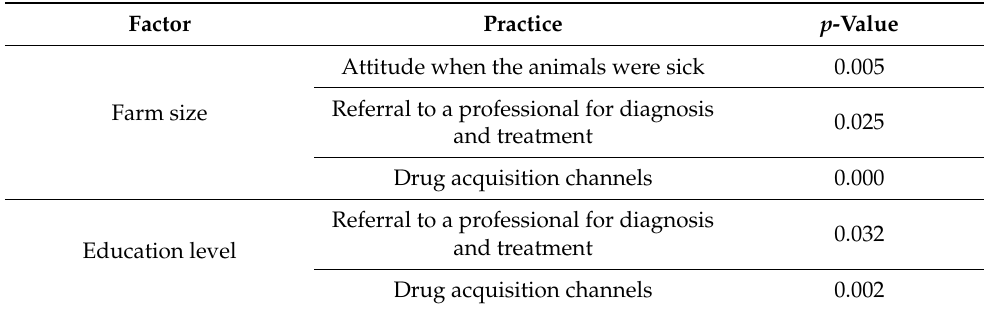
Table 4. Influence of farm size and education level on certain practices and attitudes (results of the KHI2 test).